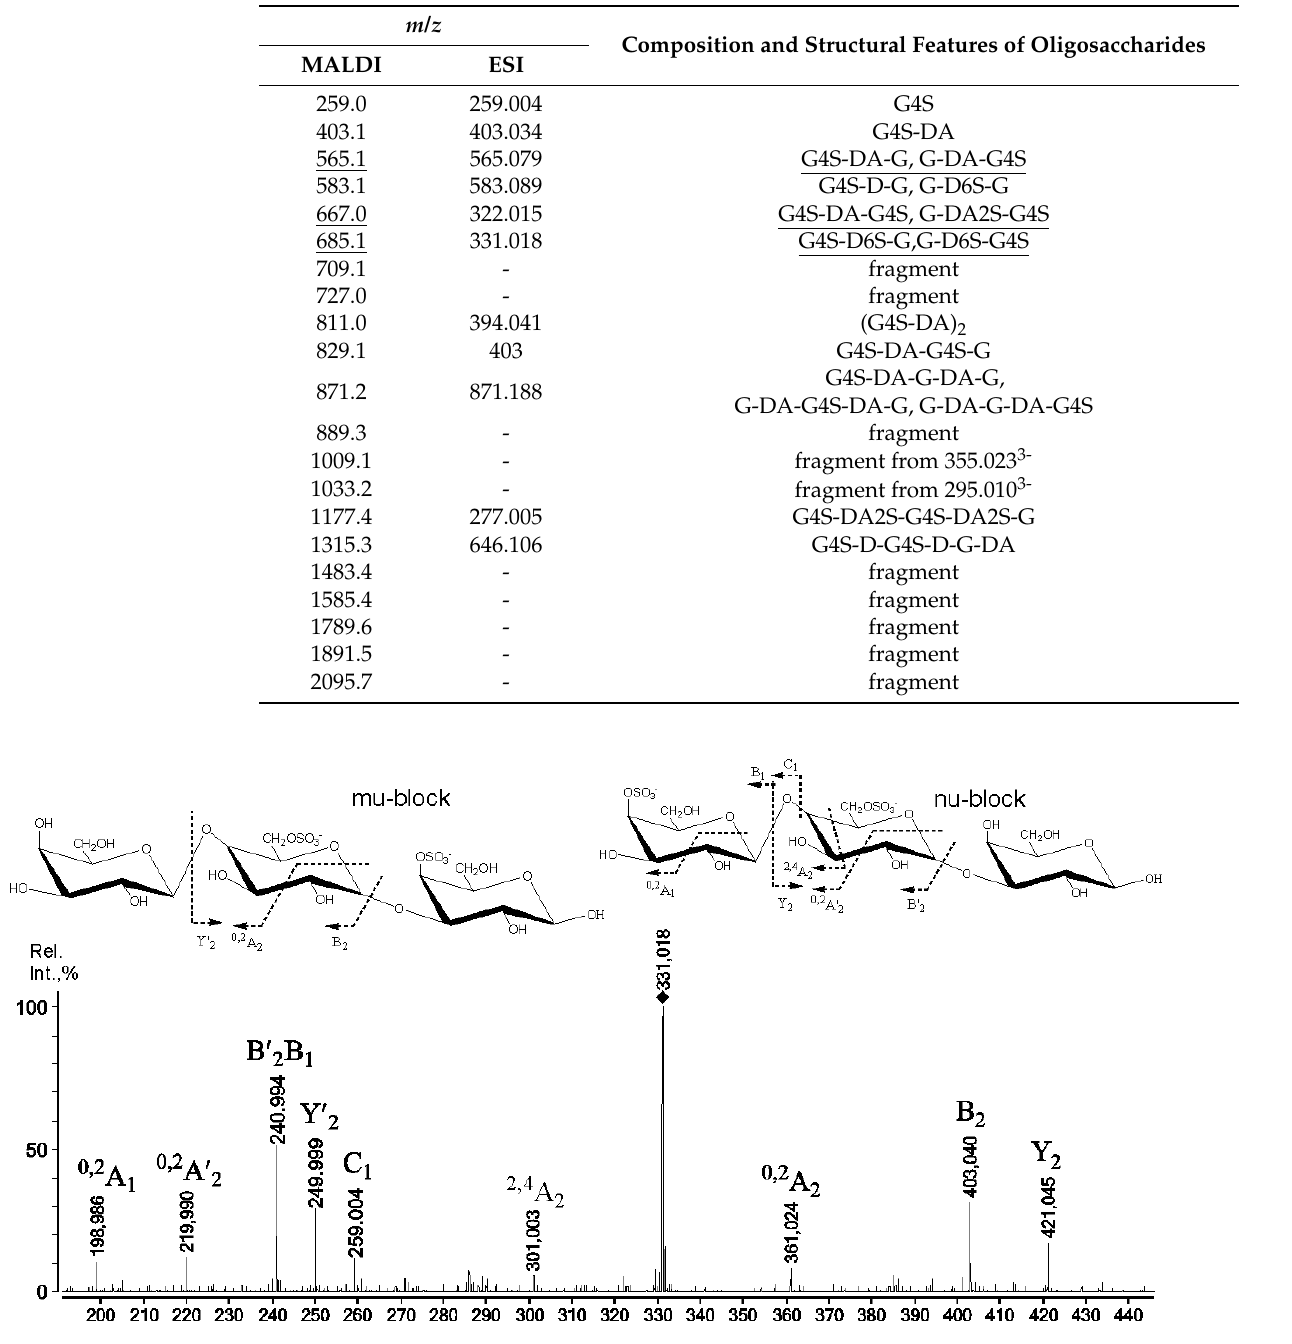
Figure 2. Negative-ion tandem ESIMS of ion at m/z 331.018 obtained through mild acid hydrolysis from RF/CRG. Additional negative-ion tandem ESIMS of the hexose-containing trisaccharide ion at m/z 583.089 also exhibited A-type fragment ions, which are rarely observable in the MS of carrageenan-derived oligosaccharides [23]. A 3,5 A 1 -type fragment ion at m/z 152.980 and a 0,2 A 1 -type fragment ion at m/z 198.984 suggested that the hexose residue in the structural variant of the ion under study (Figure 3, right side) was sulphated in position C-4 [24].